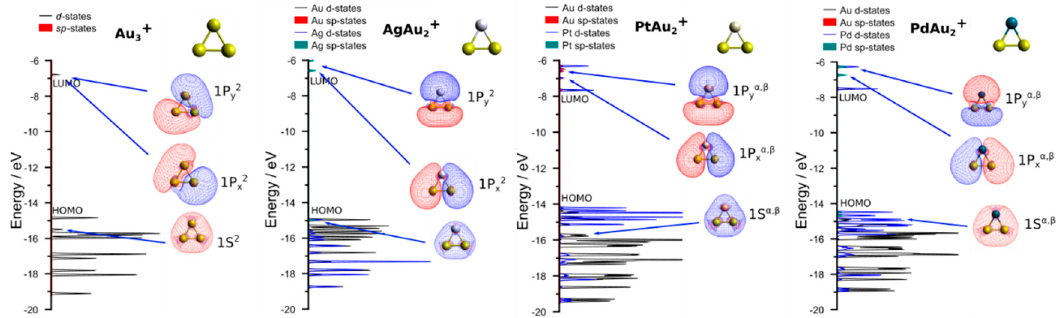
Figure 4. Total density of states of the clusters composed of N = 3 atoms. Projections into atomic states are presented in black for Au(d), in red for Au(s p ), in blue for M (d), and in green for M (s p ). The molecular orbitals of delocalized character extending over the entire cluster volume are plotted and labeled based on their nodal character (1S and 1P x,y ). The highest occupied molecular orbital (HOMO) and lowest unoccupied molecular orbital (LUMO) states are labeled as well. In the case that the cluster is open-shell, both α and β orbitals are plotted.